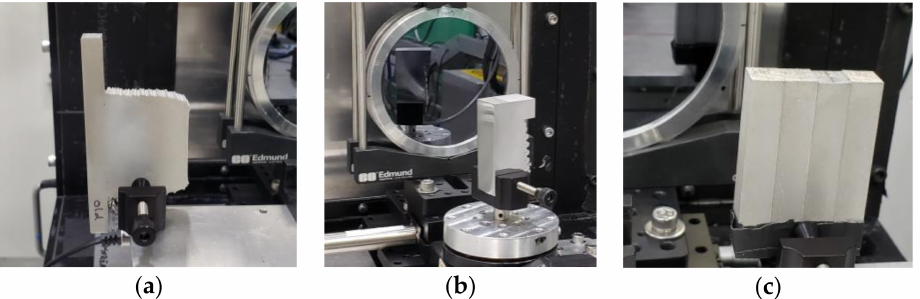
Figure 5. Samples mounted on holders in front of the neutron beam; ( a ) 10 mm slab from ingot A for 2D imaging; ( b ) 20 mm slab (polished half) from ingot B for 3D imaging; ( c ) N1, N2, N3, and N4 bars from ingot